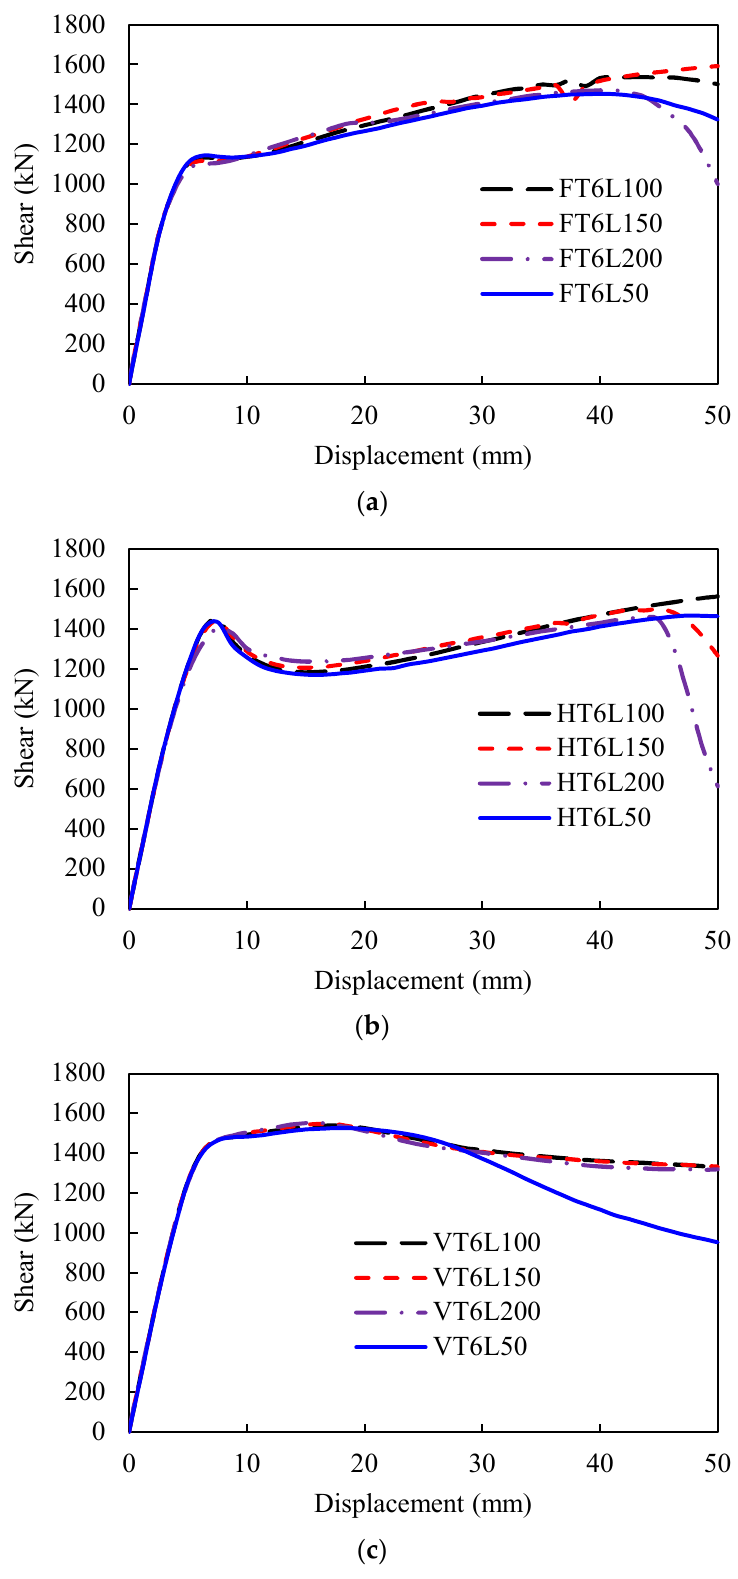
Figure 11. Effect of vertical load on the SPSWs with a thickness of 6 mm and a ( a ) flat, ( b ) horizontal corrugated, and ( c ) vertical corrugated plates.